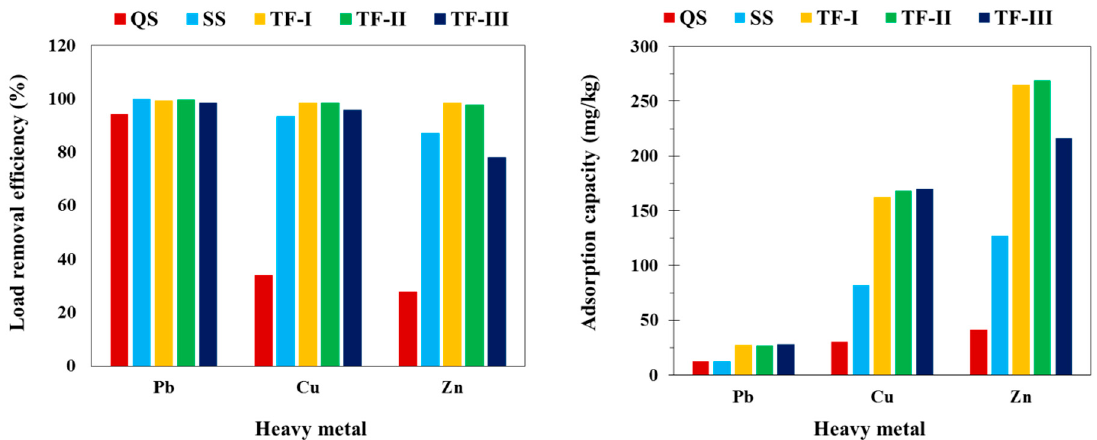
Figure 3. Overall removal efficiency ( left ) and adsorption capacity ( right ) of heavy metals by each filter media type following four successive runs (Run 1–Run 4) simulating different stormwater sources.